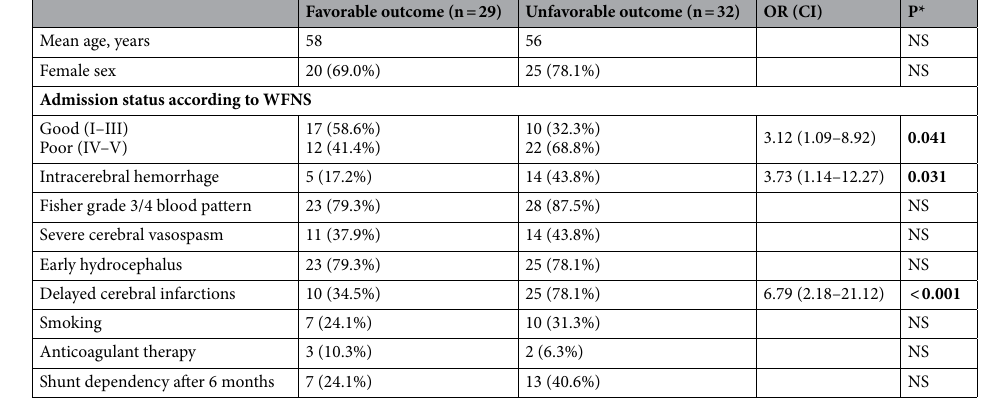
Table 2. Predictors of an unfavorable outcome in the MDRO subgroup. Outcome assed according to the modified Rankin Scale (mRS, favorable 0–2, unfavorable 3–6). OR odds ratio, CI confidence interval, MDRO multidrug resistant organism, WFNS World Federation of Neurological